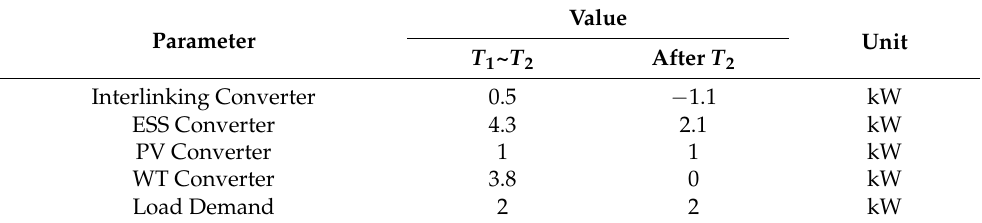
Table 4. Power flow of each power converter in operation mode 1.